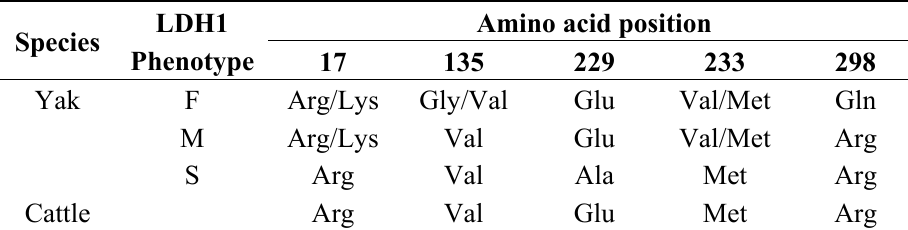
Table 2. Amino acid position differences in yak LDH1 phenotypes.